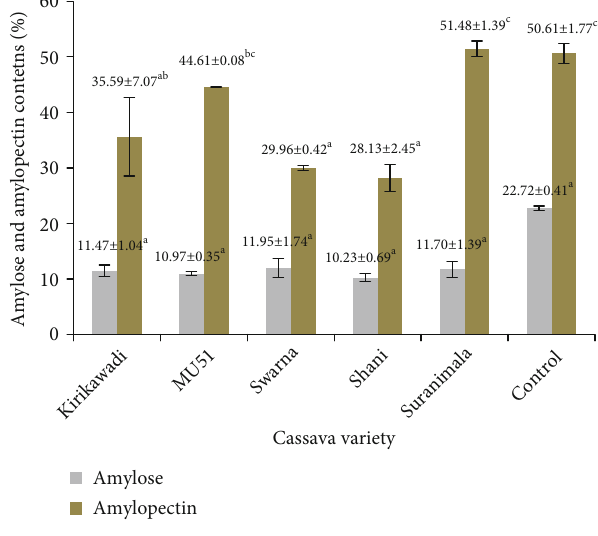
Figure 7: Amylose and amylopectin contents of cassava fl ours from fi ve Sri Lankan cassava varieties. Values are expressed as mean ± standard deviation of three independent determinations. Di ff erent superscripts represent signi fi cantly di ff erent samples ( p < 0 : 05 ). Commercial wheat fl our was used as the control.